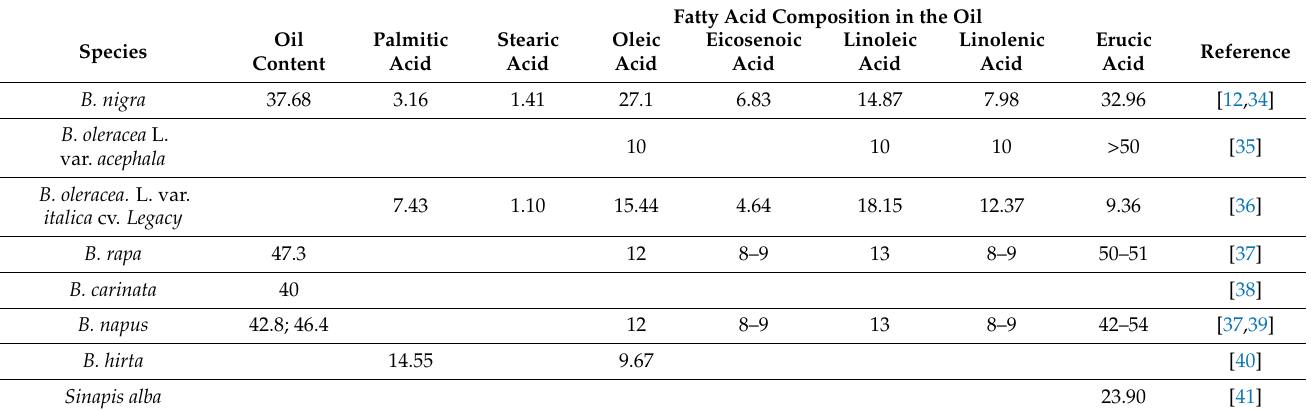
Table 2. Mean composition of oil content and main fatty acids